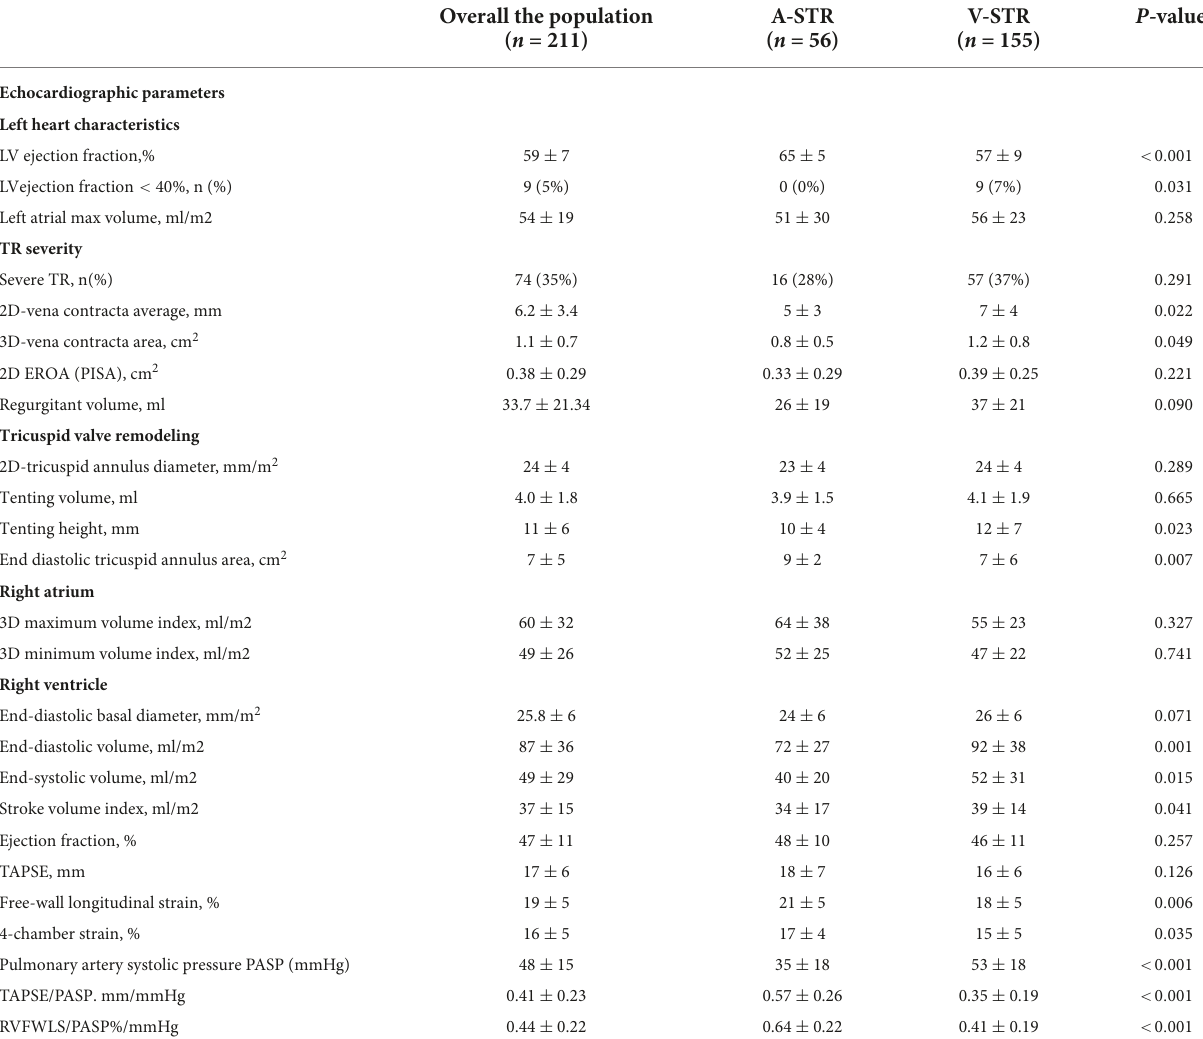
TABLE 2 Echocardiographic characteristics of patients with atrial and ventricular secondary tricuspid regurgitation.